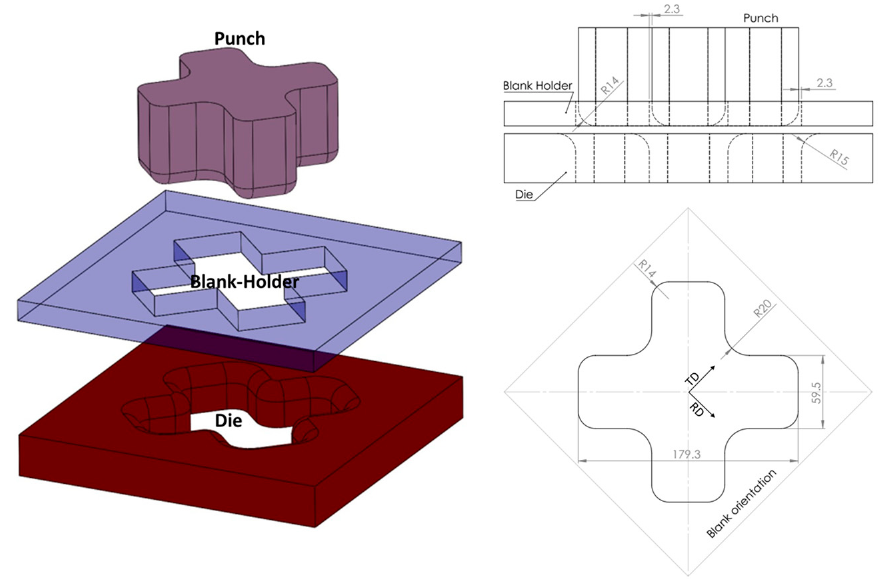
Figure 8. Cross-die deep drawing test.